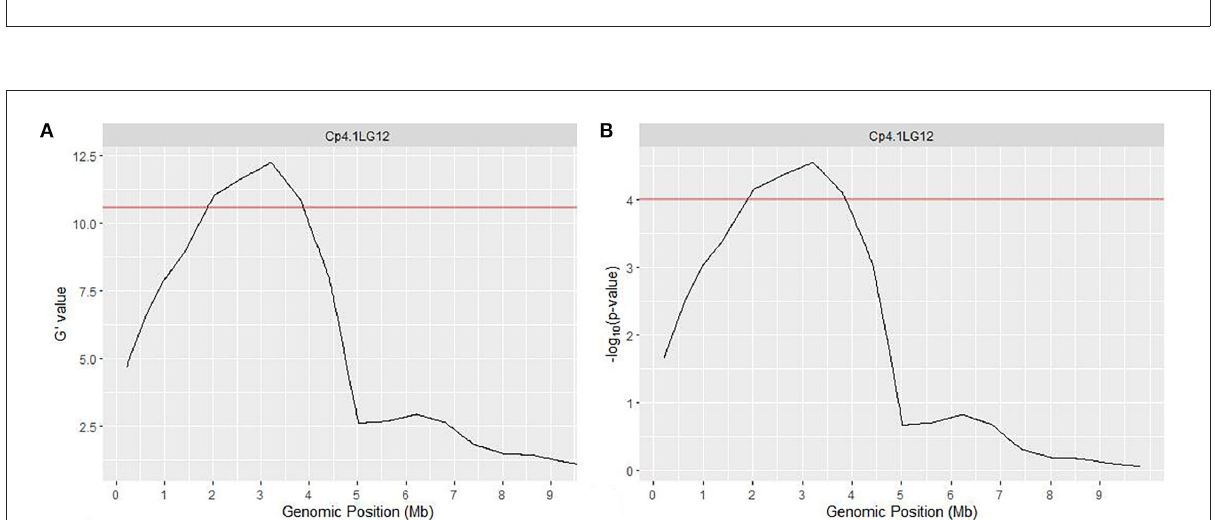
FIGURE3 QTL region governing hull-less seed trait in C . pepo on chromosome 12 using G’ (A) and p -value (B) . Red line indicates a significant threshold for FDR (false discovery rate), q =